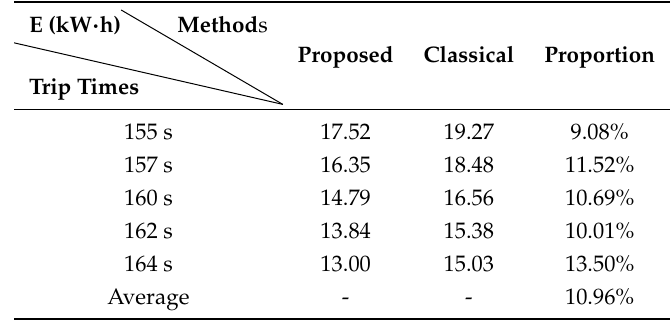
Table 3. Energy efficiency comparison between the proposed and classical algorithm with different trip